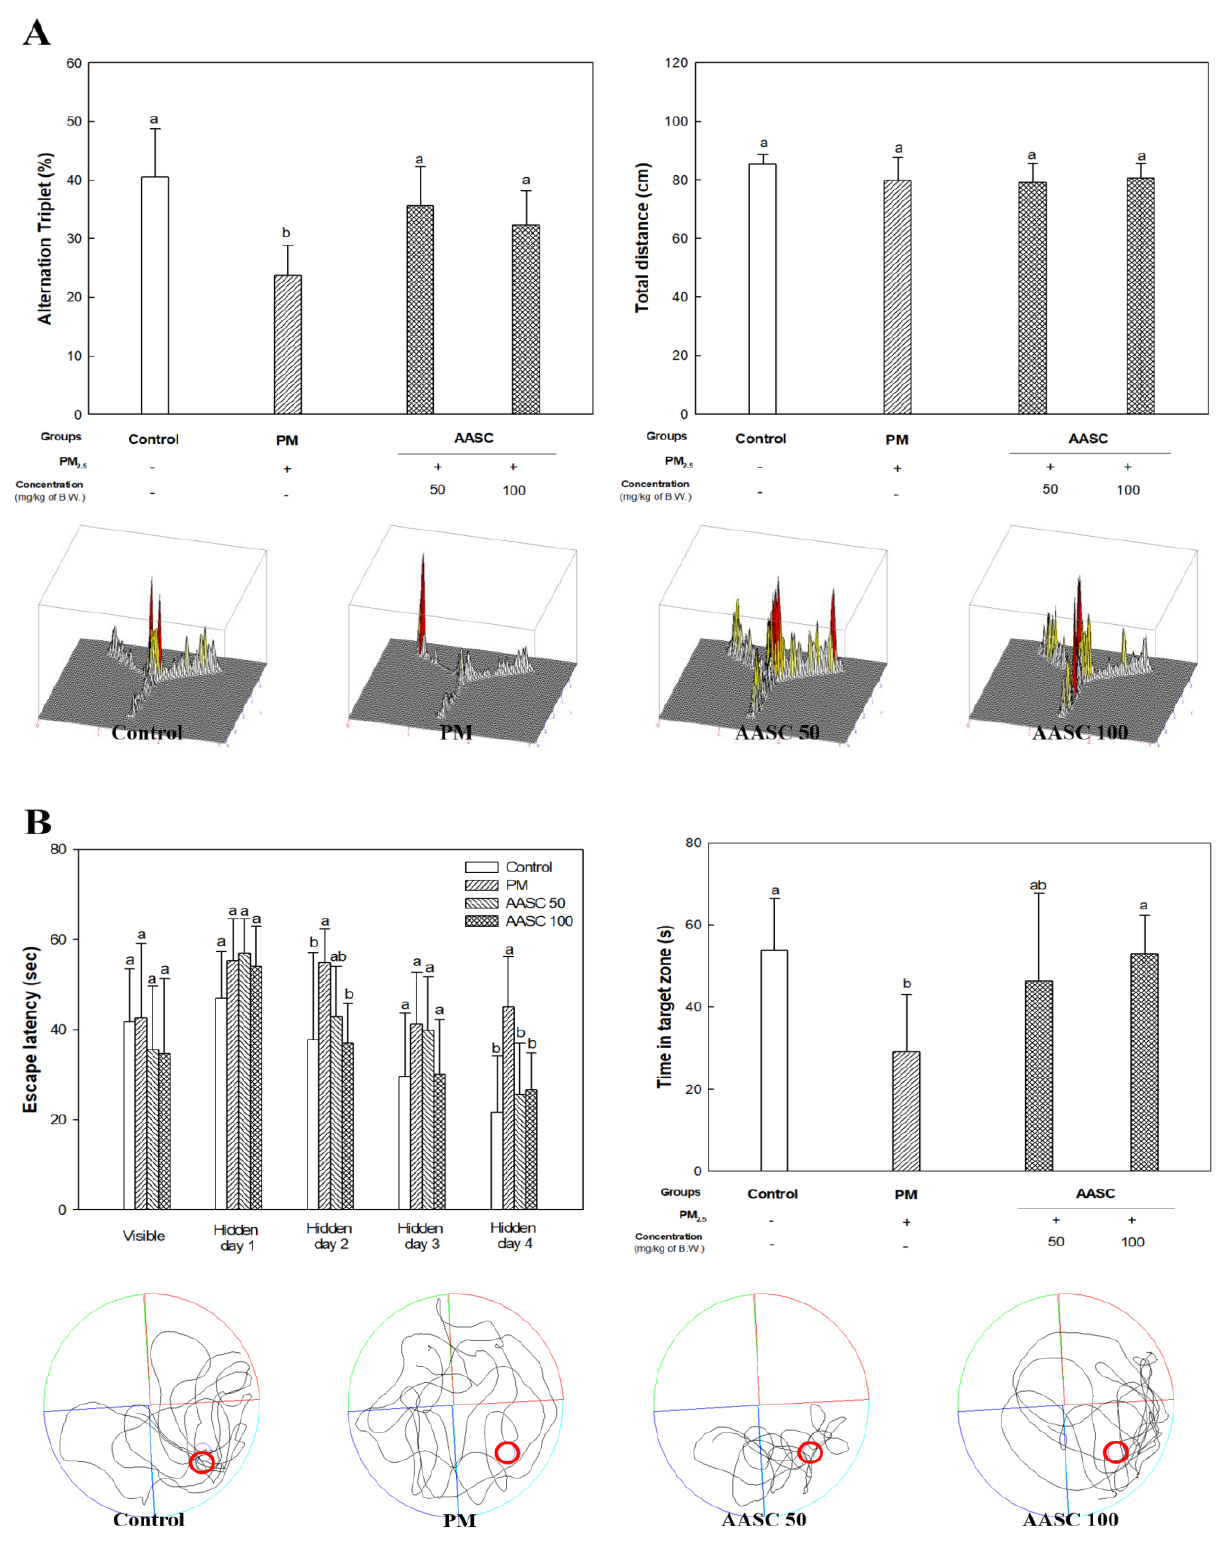
Figure 2. Improvement effect of AASC on cognitive dysfunction of mice exposed to PM 2 . 5 . ( A ) Y- maze test and ( B ) Morris water maze test. Results are indicated as mean ± SD ( n = 9). Different small letters represent the statistical difference ( p < 0.05) of each group in a high order.